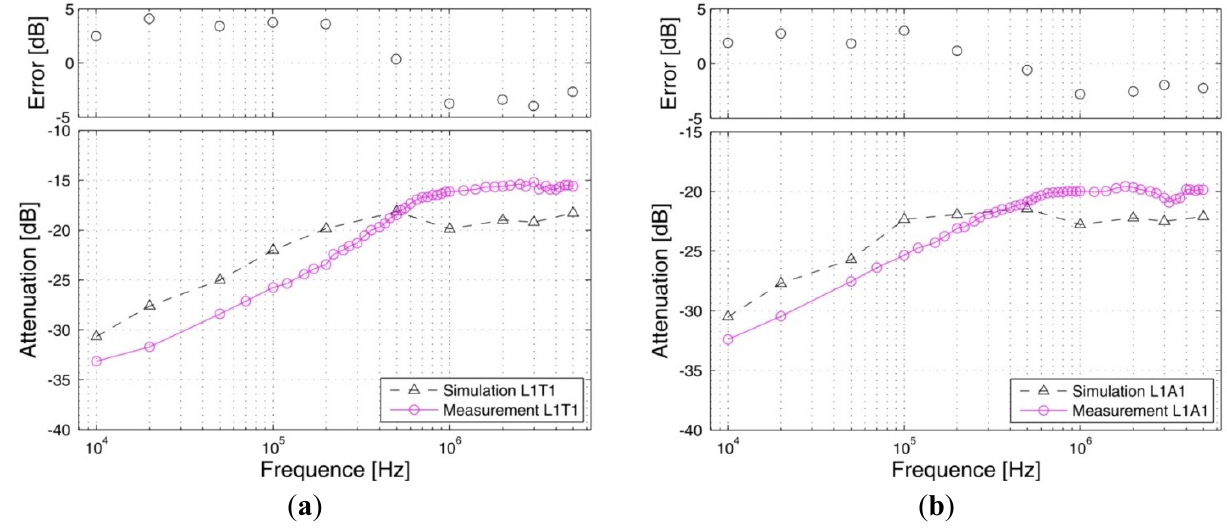
Figure 10. The simulation results and the measurement results of the LIT1 path ( a ) and the L1A1 path ( b